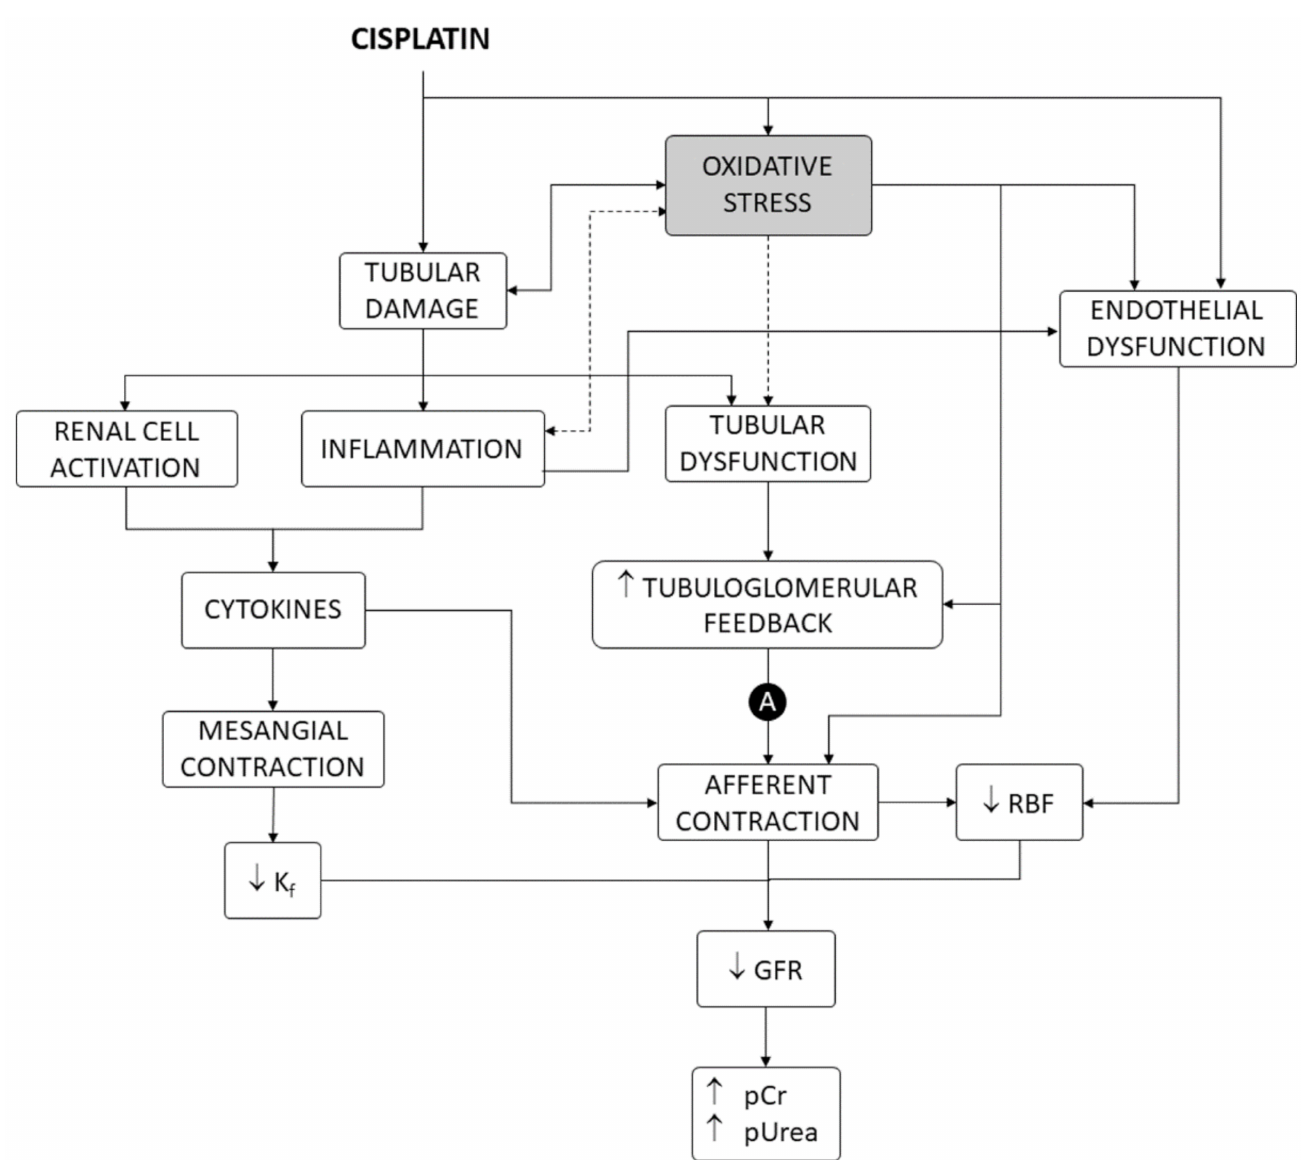
Figure 1. Mechanisms of cisplatin nephrotoxicity, including oxidative stress as a contributing factor. A, autoregulation of renal blood flow and intraglomerular blood pressure. GFR, glomerular filtration rate. Kf, ultrafiltration coefficient. pCr, plasma creatinine concentration. pUrea, plasma urea concentration. RBF, renal blood